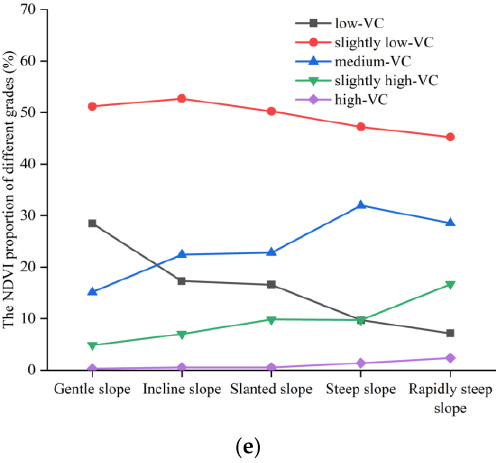
Figure 16. The proportion of different vegetation cover grades on different slopes: ( a ) 2017; ( b ) 2018; ( c ) 2019; ( d ) 2020; ( e ) 2021.